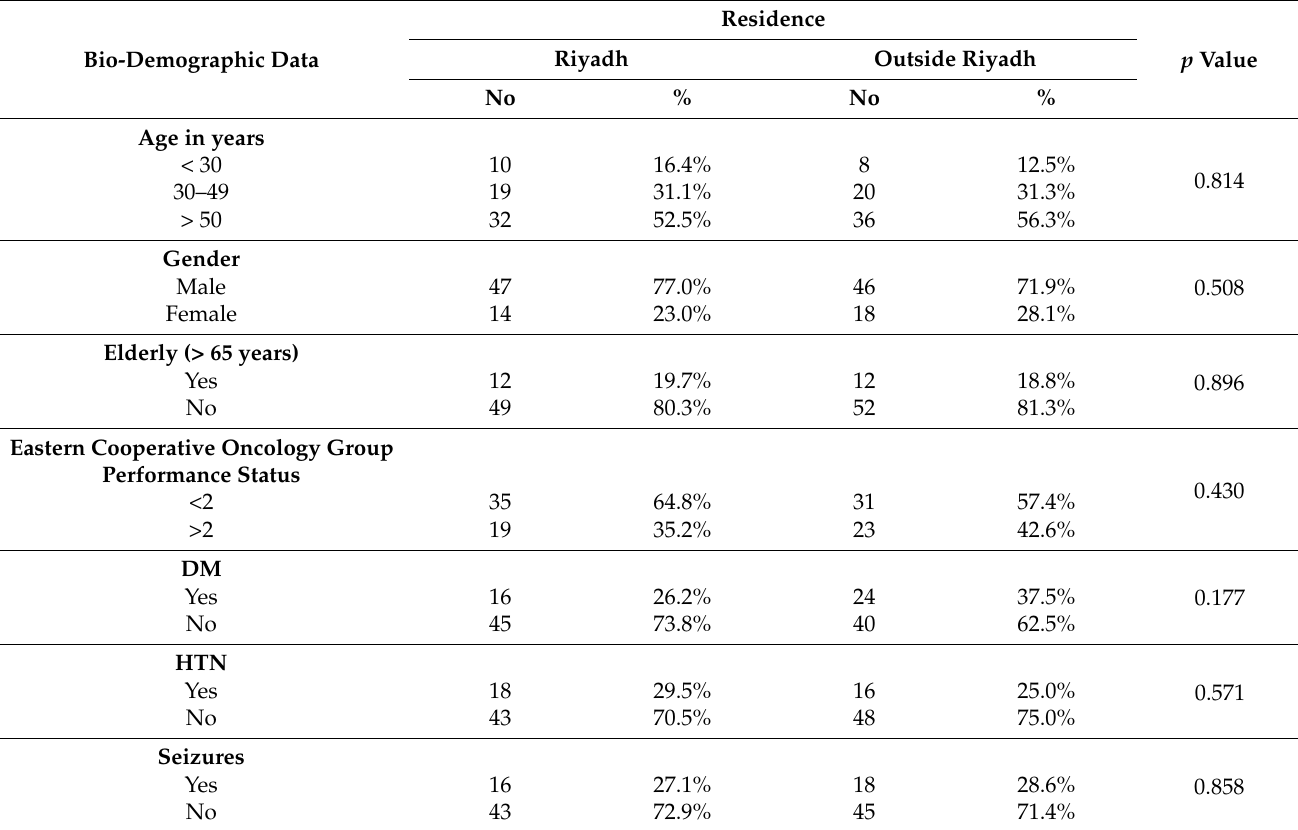
Table 1. Distribution of study sample characteristics by